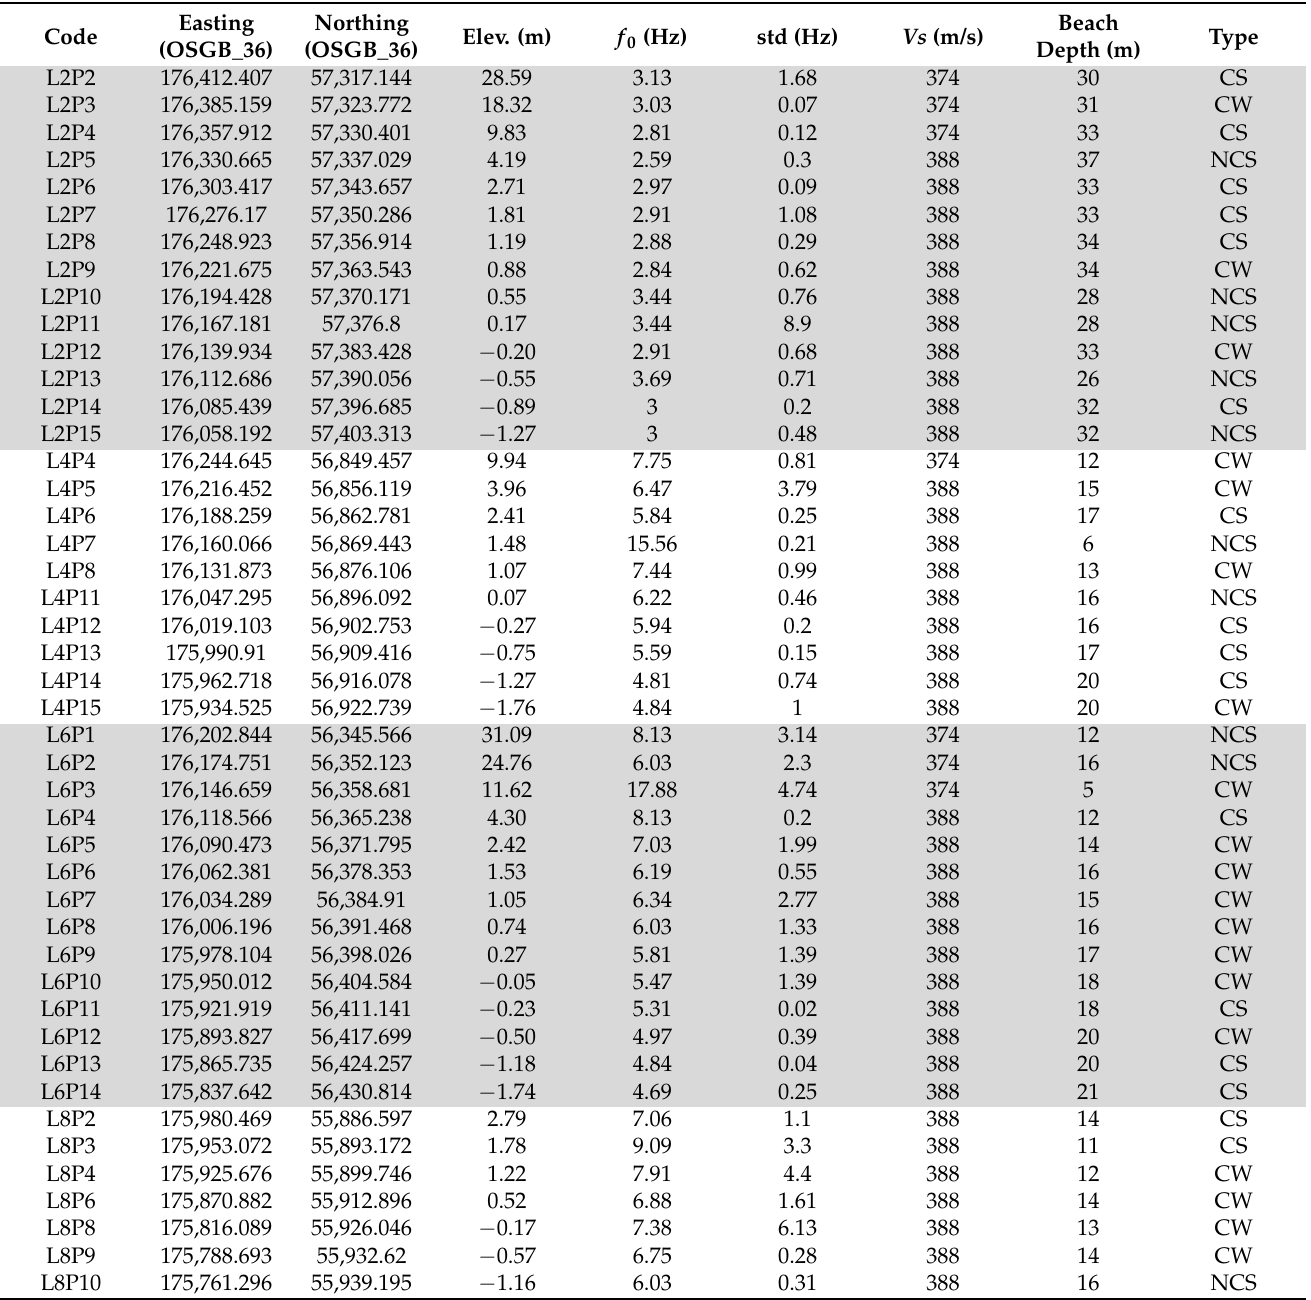
Table A1. For each one of the 149 locations sampled with the PSS method, the coordinates (in British National Grid coordinate system or EPSG:27700-OSGB 1936), the peak frequency and standard deviation of the peak frequency, the Vs value that best fits the peak frequency, and the estimated beach thickness resulting from applying Equation (1). Background colour alternates between grey and white to visually separate the different